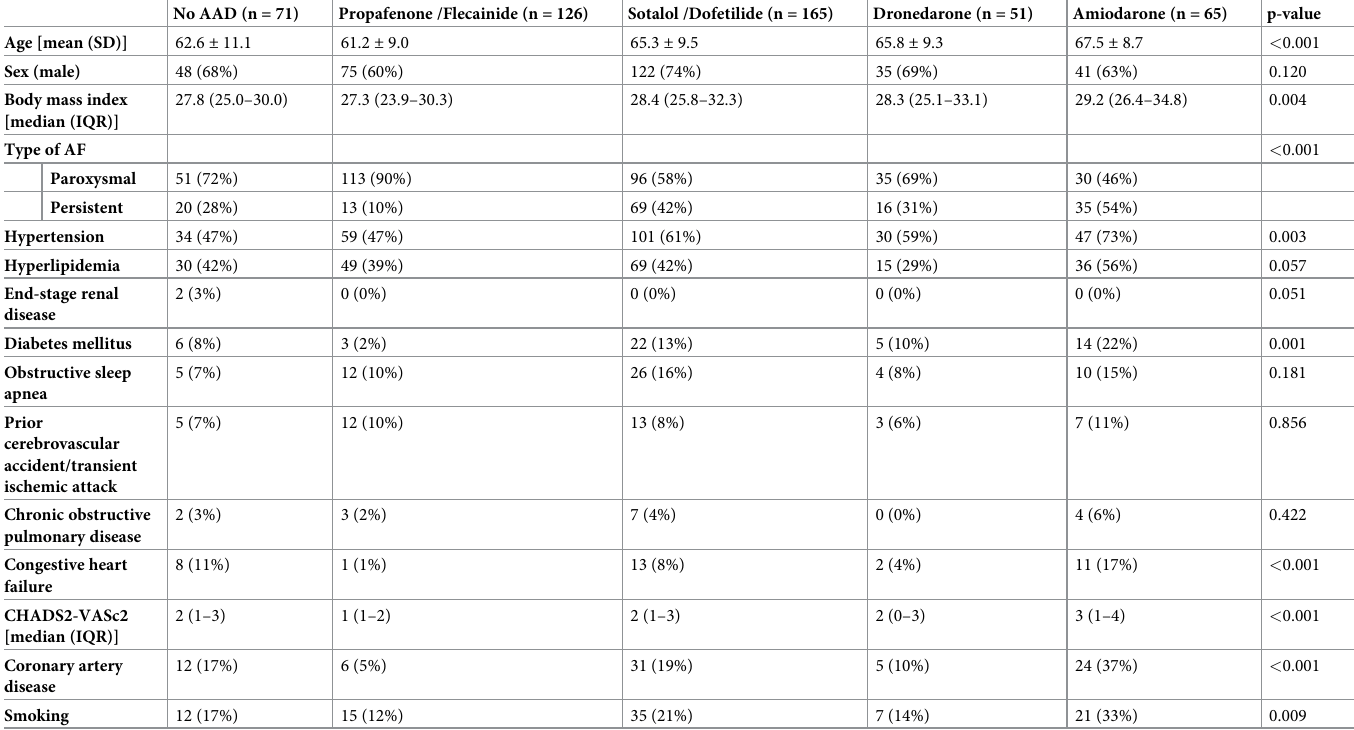
Table 1. Baseline patient characteristics stratified by choice of AAD immediately after PVI ablation for AF. No AAD (n =